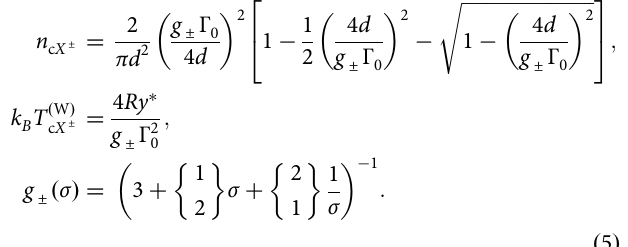
ffiffiffiffiffiffiffiffiffiffiffiffiffiffiffiffiffiffiffiffiffiffiffiffiffiffiffi